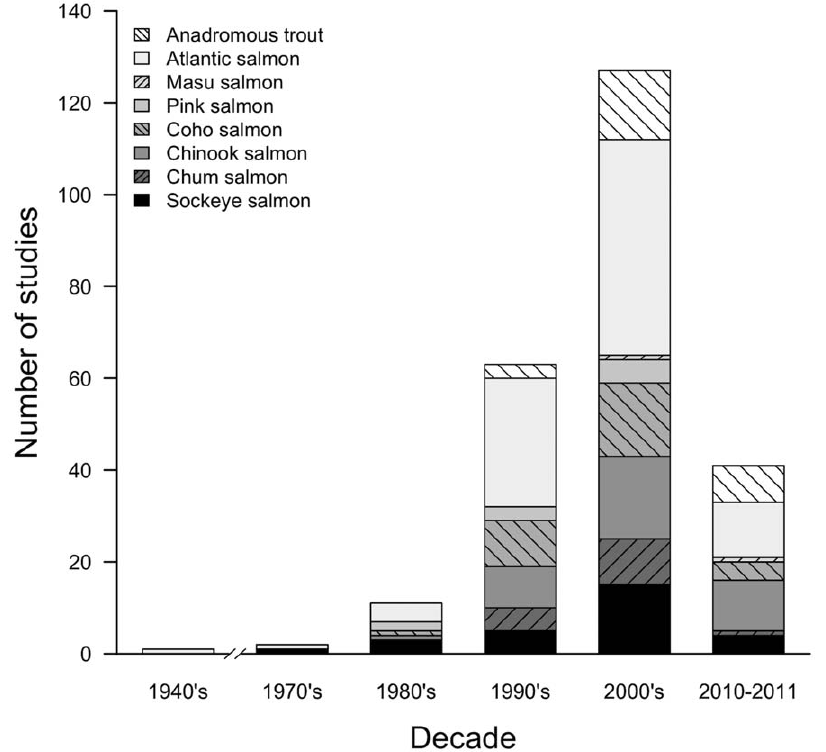
Figure 1. Number of study of particular species by publication decade. Total number of studies (n=245) exceeds that of reviewed papers (n=207) because many studies investigated more than one species. Steelhead, cutthroat, brown and sea trout were combined into ‘‘Anadromous trout’’.